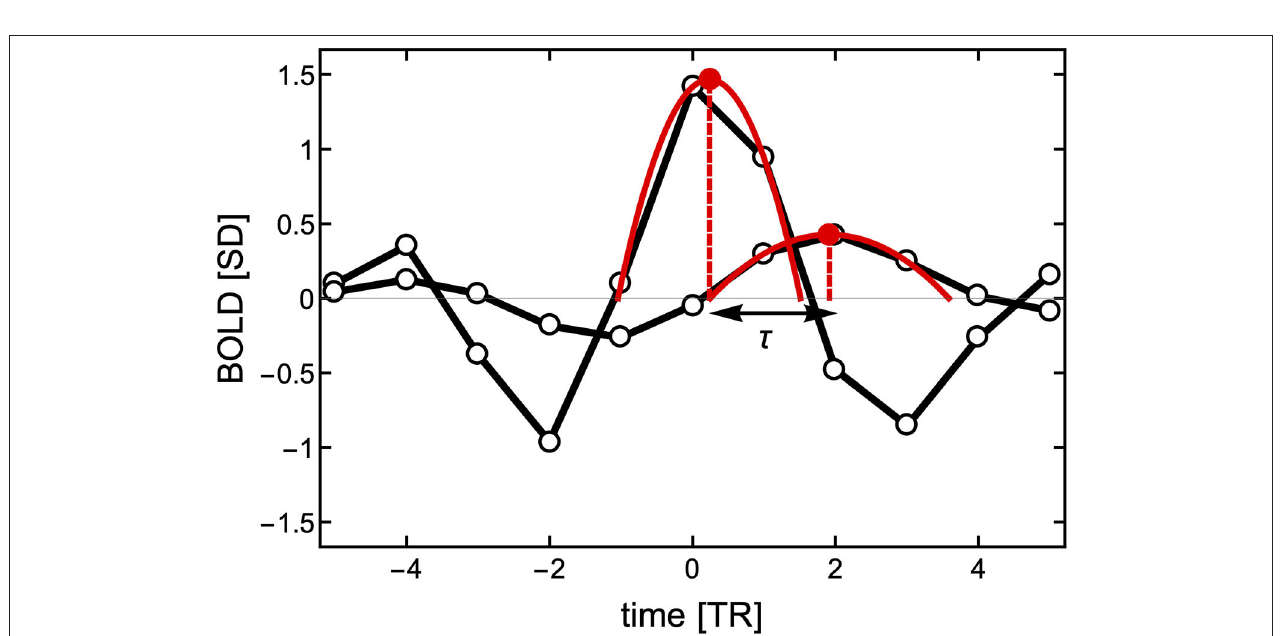
FIGURE 3 | Estimation of the delay τ between two events with finer resolution than the TR. First, the peak of the source event is centered at time TR = 0 to estimate the closest peak of the target signal (here around time TR = 2). To obtain a better resolution of the delay between the two signals, two parabolas are fitted to three points in each of the peaks. The time between the peaks of the parabolas is used to define the delay τ .